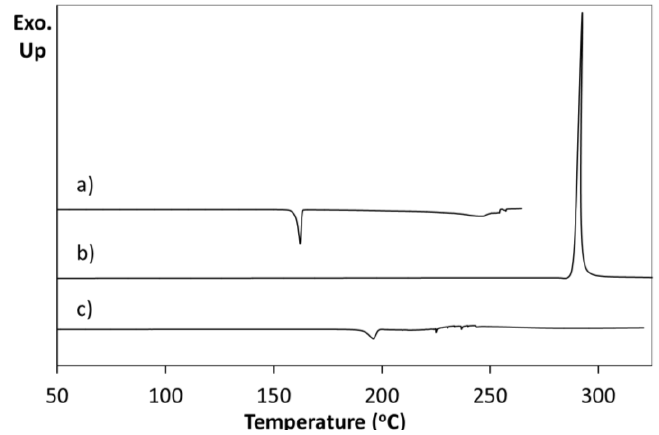
Figure 3. Differential scanning calorimetry of ( a ) 5FC-4Cl35DNBA; ( b ) 4Cl35DNBA; ( c ) 5FC.